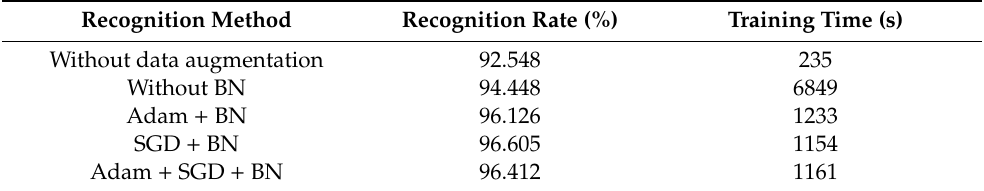
Table 2. Recognition rates and training times of different methods.